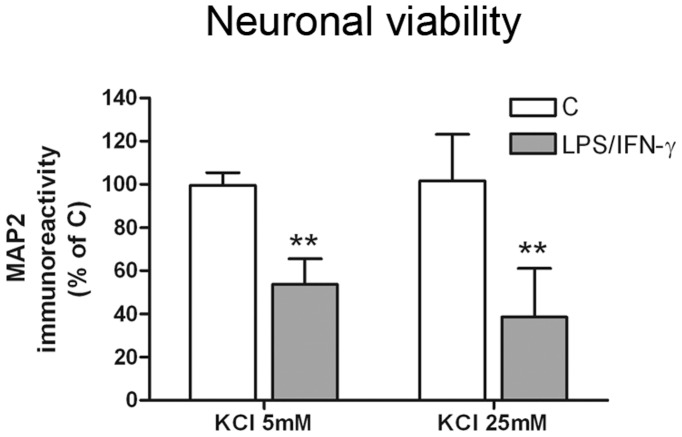
High extracellular K+ concentration did not potentiate reactive glia-induced neurotoxicity in neuron-primary microglia co-cultures.Neuronal viability (MAP2-ABTS-ELISA assay) in neuron-primary microglia co-cultures grown in 5 mM and 25 mM KCl and treated with 100 ng/mL LPS +30 ng/mL IFN-γ for 24 h. Results are presented as % of MAP2 immunostaining in control co-cultures grown in 5 mM KCl. Bars are means + SEM of four independent experiments. **p<0.01 vs each control; two-way ANOVA (repeated measures) and Bonferroni post-test.